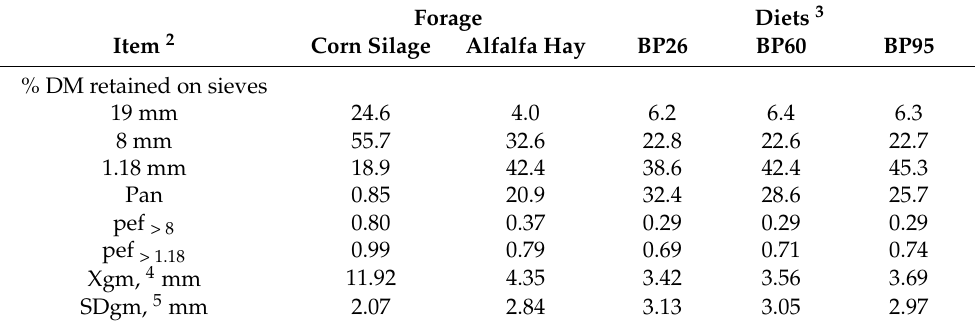
Table 2. Physical characteristics of forages and diets 1